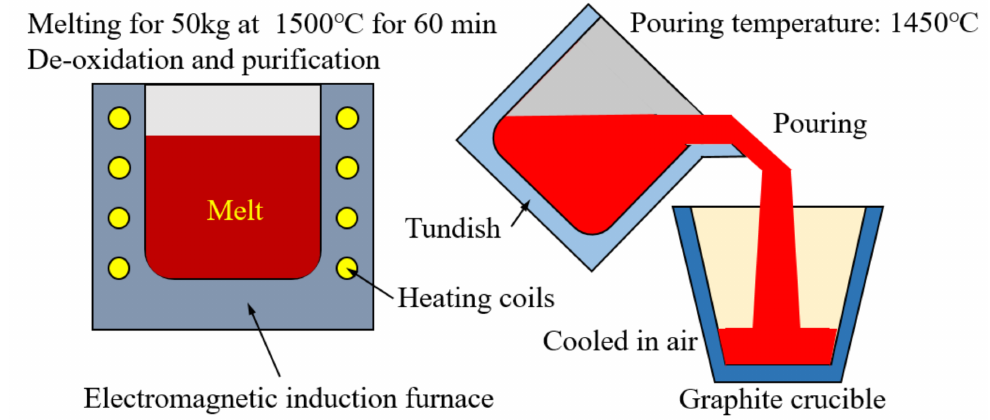
Figure 1. Schematic diagram of the casting